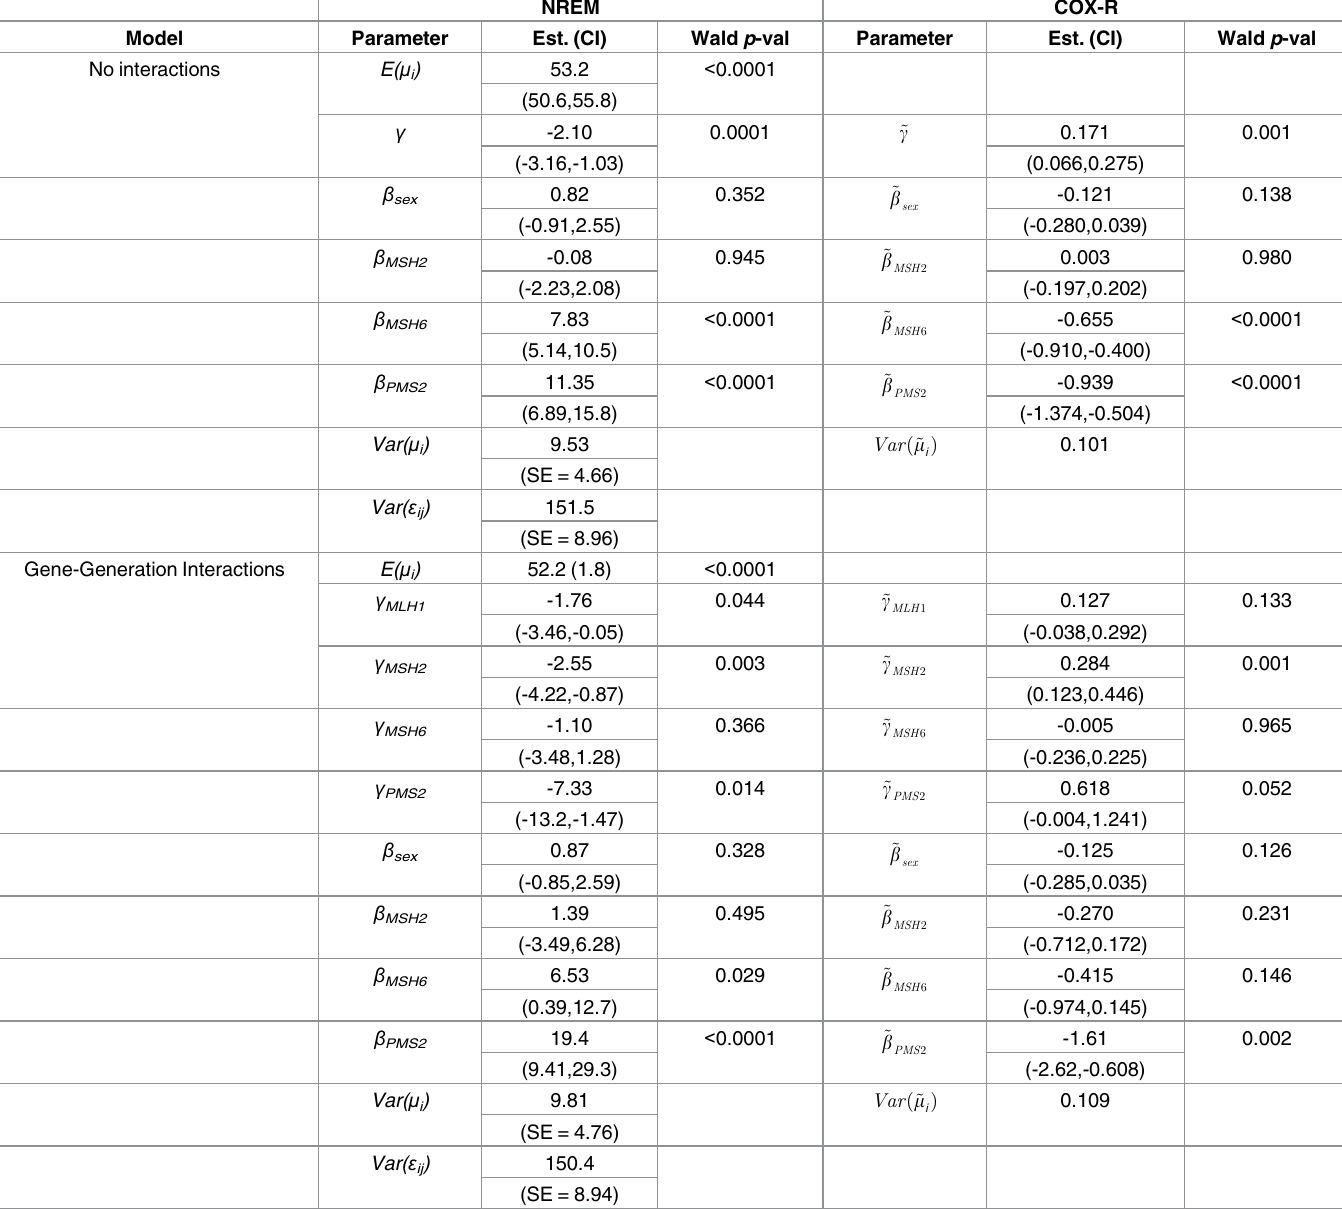
Table 3. Complete results for the NREM and COX-R models, without and with the gene-generation interactions (Est = Estimate, CI = 95% Confi- dence Interval; SE = standard